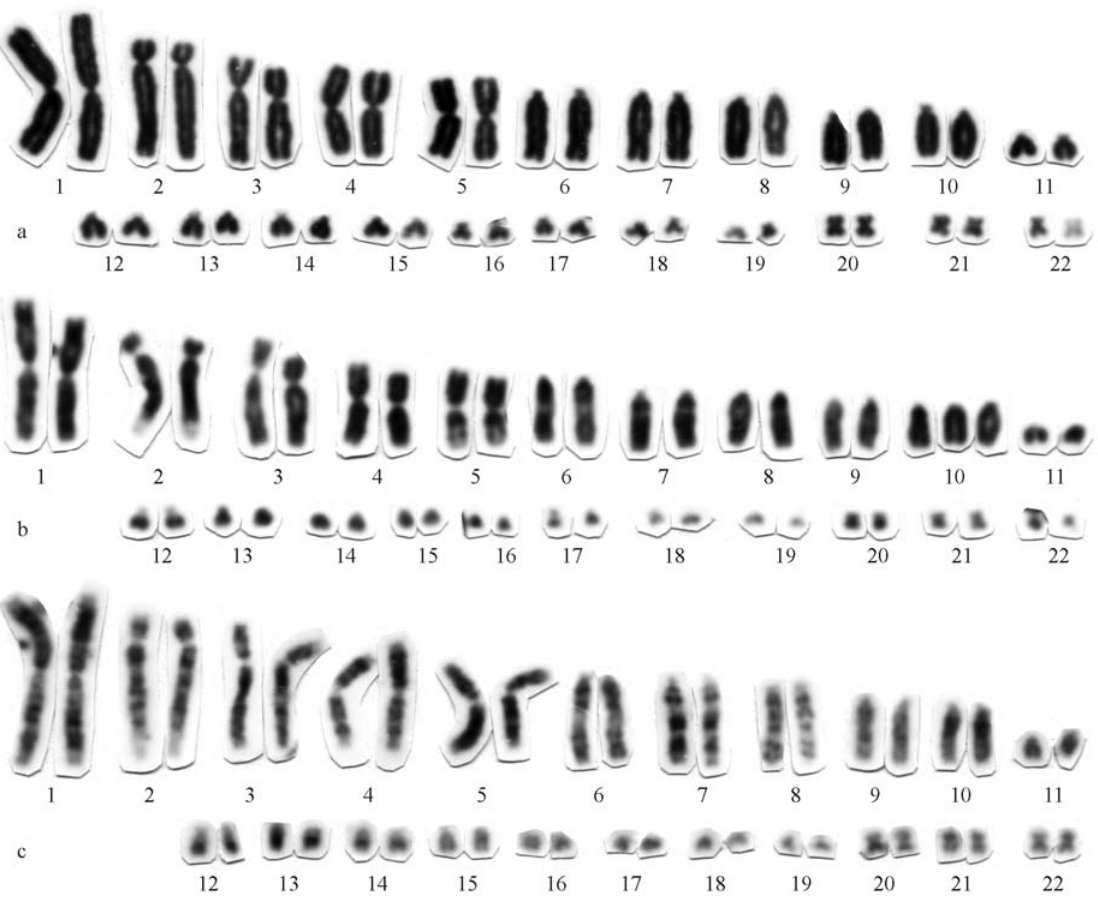
Figure6 -Karyotypesof Psilophthalmuspaeminosus (2n=44,20M+24m).(a)conventionalGiemsastaining.(b)RBG-bandingshowingthelatereplicat- ing band at the distal region of the long arm of pair 2 and trisomy of the pair 10. (c) RBG-banding of a standard metaphase.